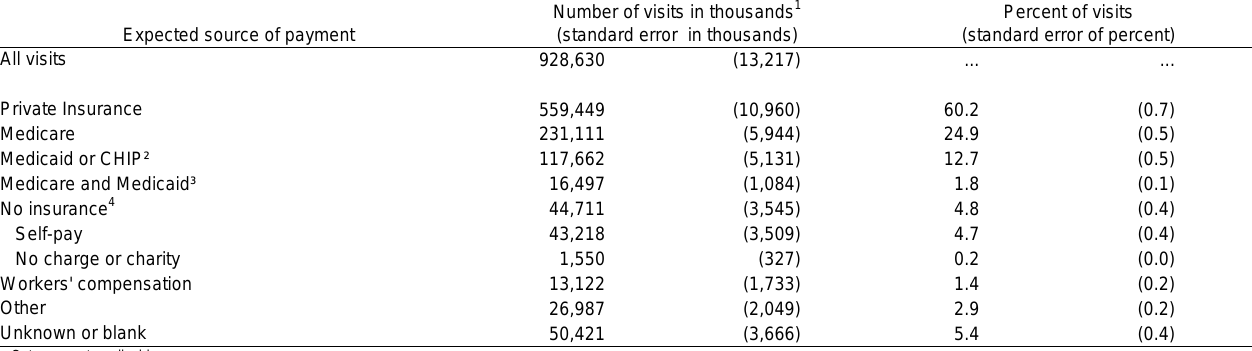
Table 7. Expected sources of payment at office visits: United States,